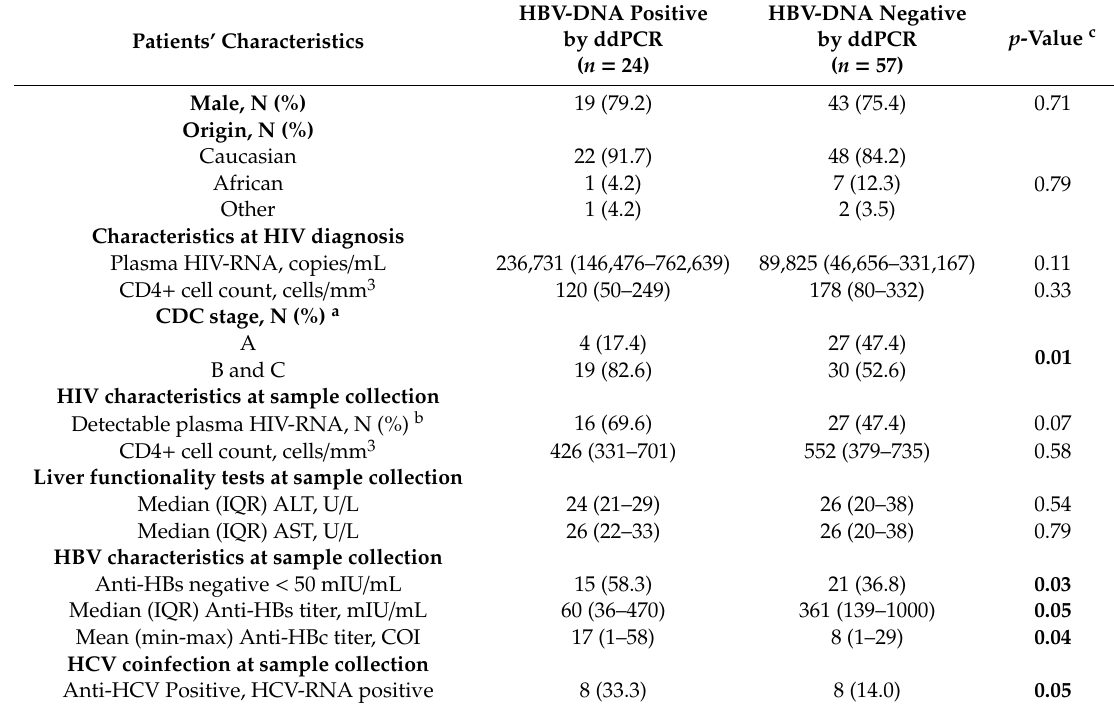
Table 3. Factors correlated with detection of HBV cryptic viremia.